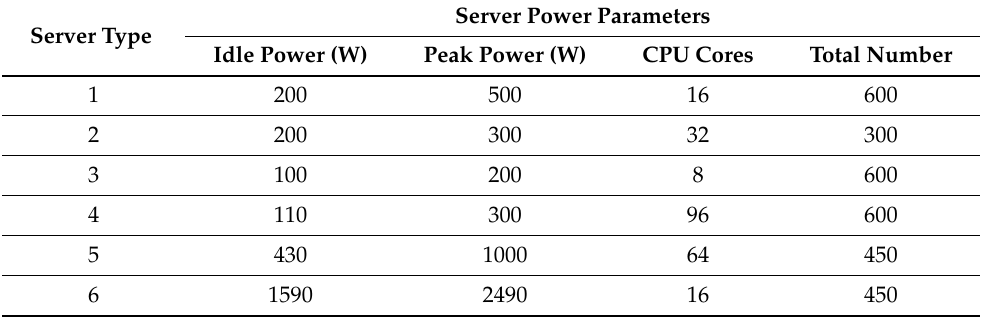
Table 2. Server parameters in the